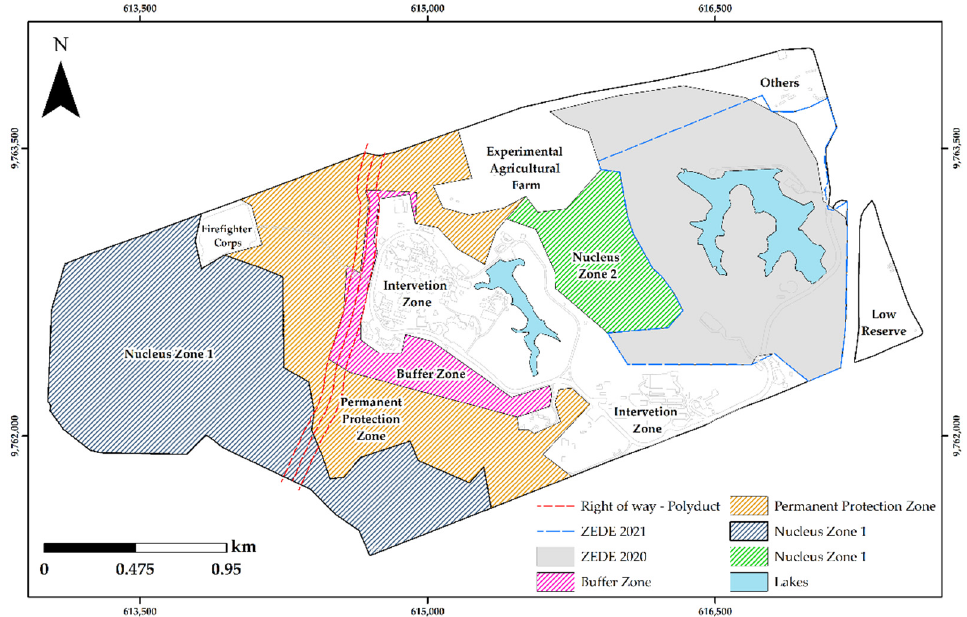
Figure 6. Map of protection zones of the ESPOL